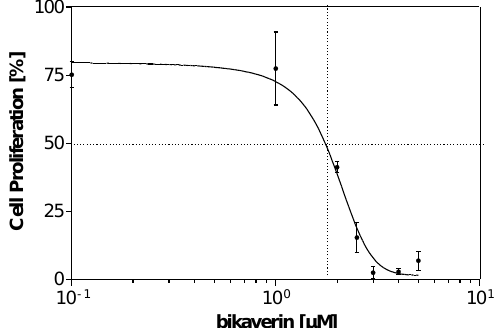
Figure 5. Quantification of the antiproliferative effect of bikaverin using EdU assay on MCF7 ( Black ), A431 ( Dark grey ) and A427 ( Light grey ) cells after 24 h of incubation. Results are shown as percent of proliferating cells relative to control cells (with 1% DMSO) and represent the mean (± SD) of three independent experiments.